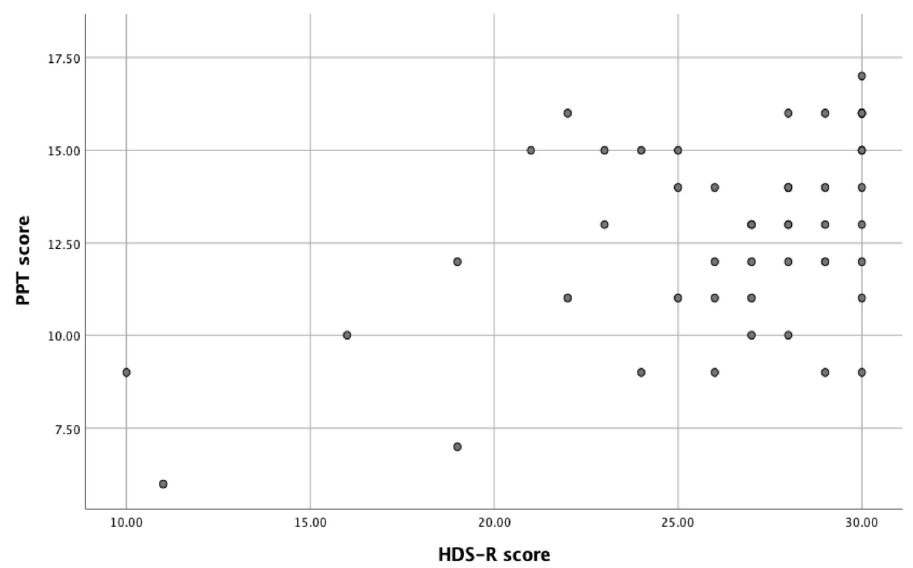
Figure 3. Correlation between HDS-R score and PPT score.